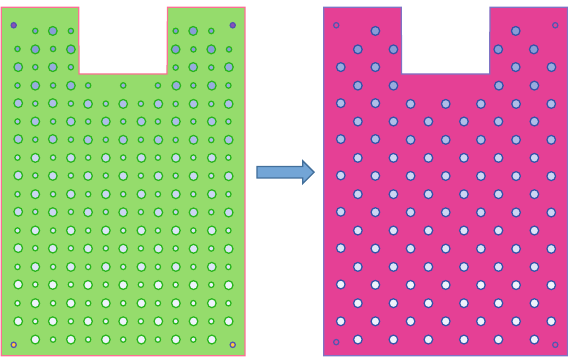
Figure 10: Heat absorber plate with removing all the small corrugations (right).